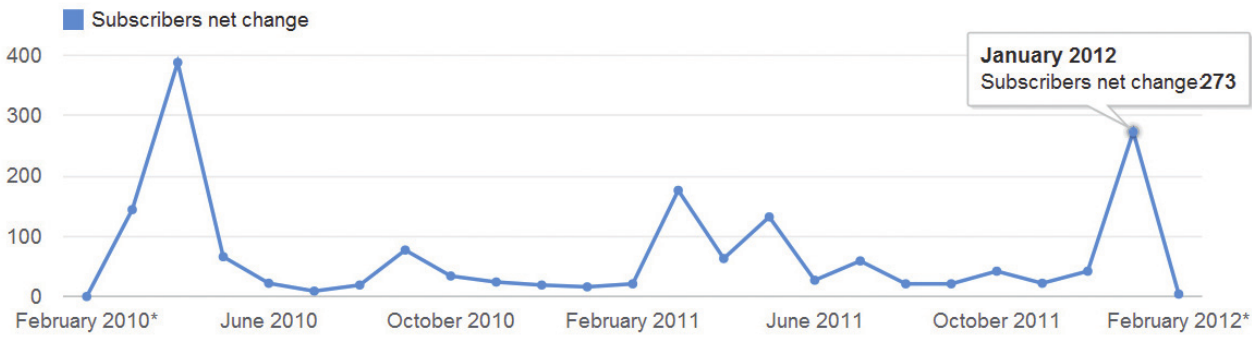
Figure 7. Monthly number of subscribers to the INGV YouTube channel from the opening* to date*. As well as peaks related to specific events, there is a constant rate of 20-40 new subscribers every month. In January 2012, we had the second highest peak (from the time of the opening of the INGV YouTube channel), with 273 new subscribers.